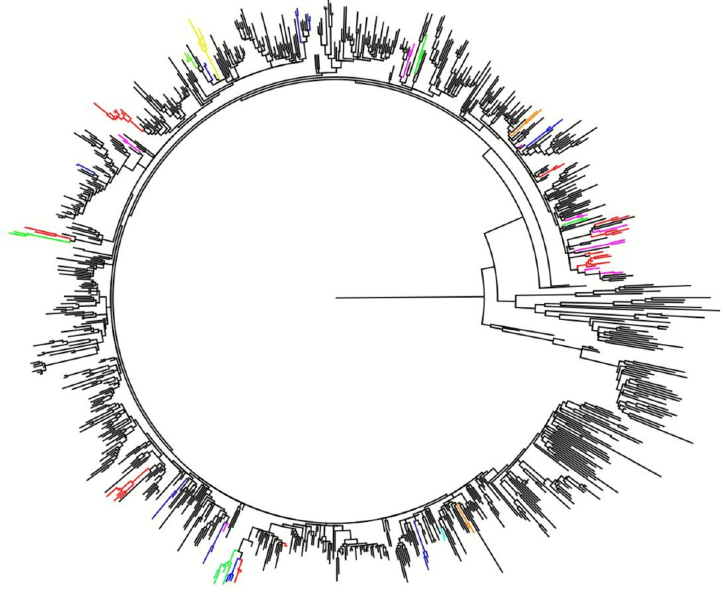
Fig 1. Phylogenetic clustering and genotyping of samples from HIV patients diagnosed between 1999 and 2012. Phylogenetic tree depicting newly diagnosed patients with HIV in Korea between 1999 and 2012. Of the 927 patients, 104 patients are shown here based on 37 transmission clusters, grouped by color, and labeled as clusters 1–37, with each tip representing an individual patient. Each depicted cluster satisfied greater than 90% support based on the bootstrap resampling cut-off. The scale line indicates genetic